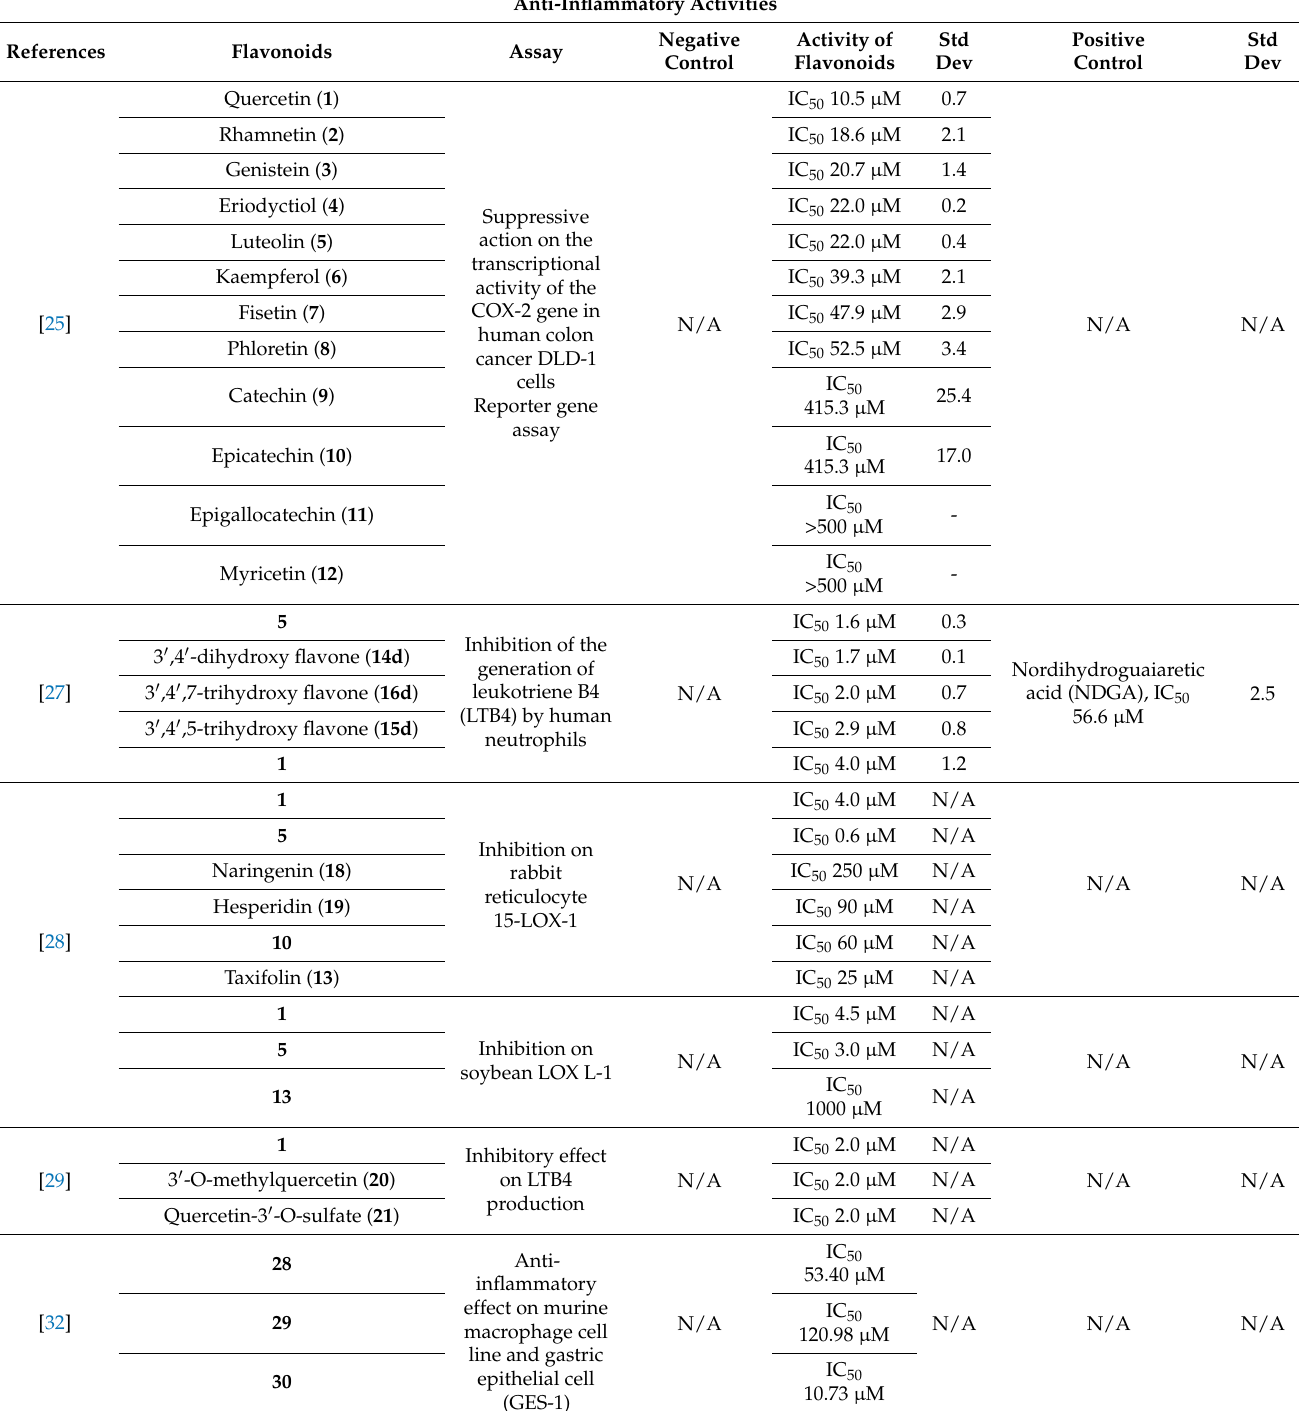
Table 1. In vitro anti-inflammatory and antidiabetic activities of flavonoids. Anti-Inflammatory